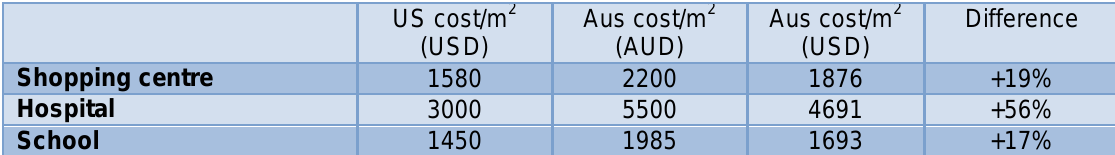
Table 3 2008: Turner & Townsend data, annual average exchange rate (1.17AUD=1USD)